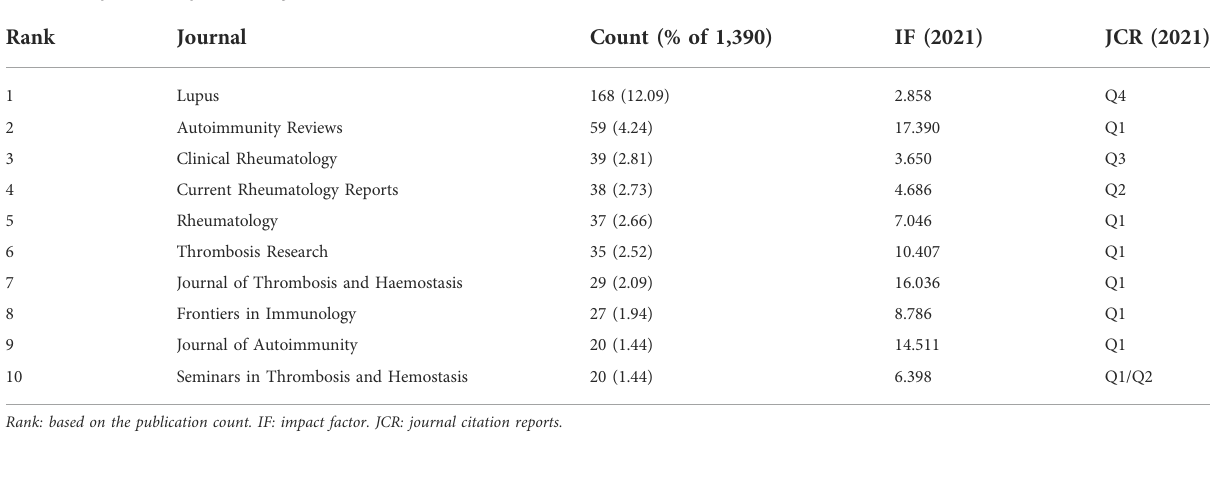
TABLE 5 Top 10 most productive journals related to APS.